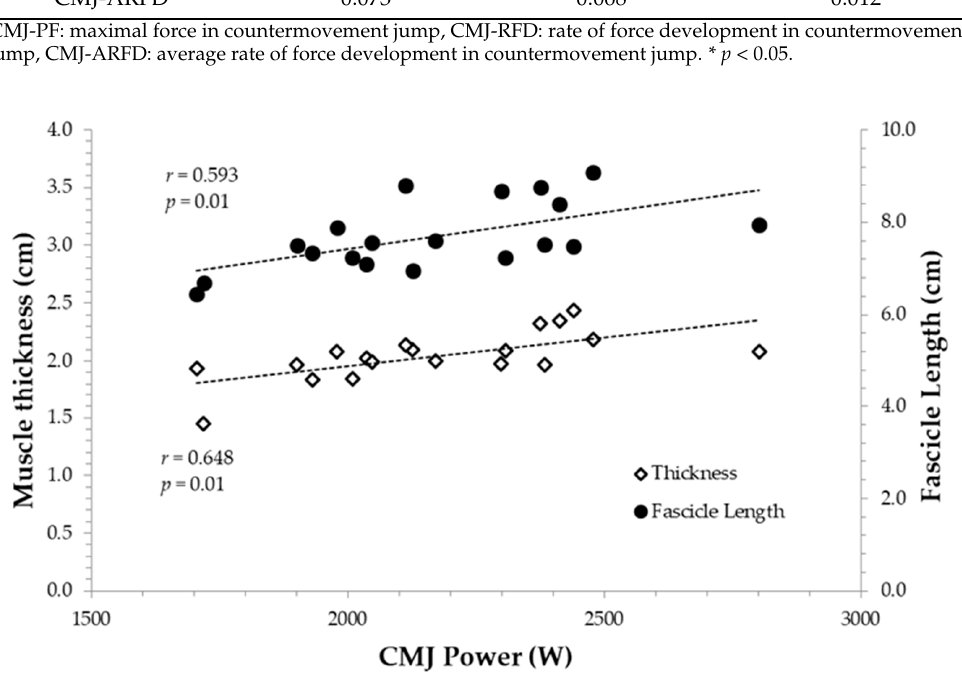
Figure 3. Correlations between CMJ power and VL muscle thickness and fascicle length.